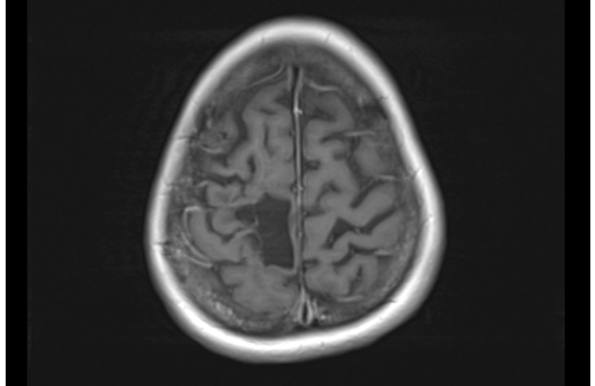
Fig. 1i. Axial T1-weighted MRI scan showing disappearance of the multiloculated contrast-enhanced lesions.